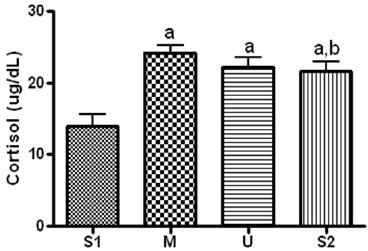
Figure 11. Serum Cortisol concentration in different locations. Values are mean ± S.D. Significance ( p < 0.05) is denoted by a: Relative to S1 and b: Relative to M. S1: Before start in Seoul, M: Moscow U: Ulaanbaatar S2: Return to Seoul.